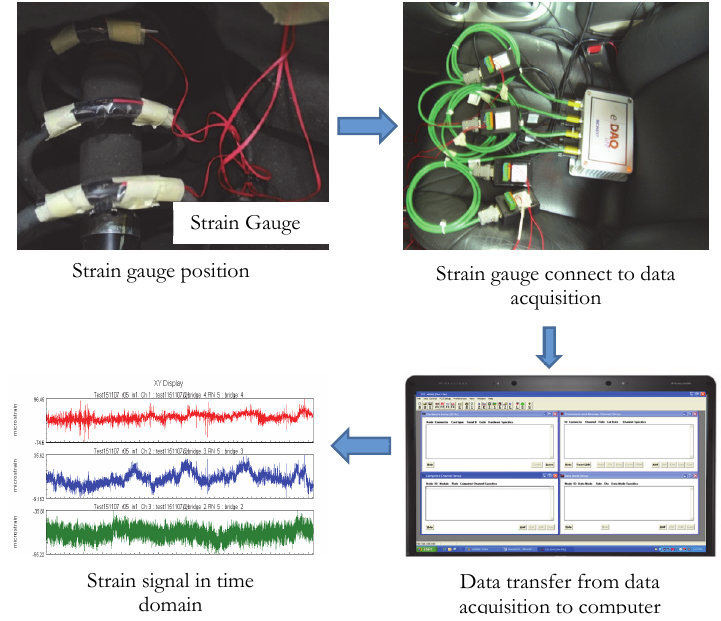
Figure 2: A diagrammatic process flow for fatigue signal